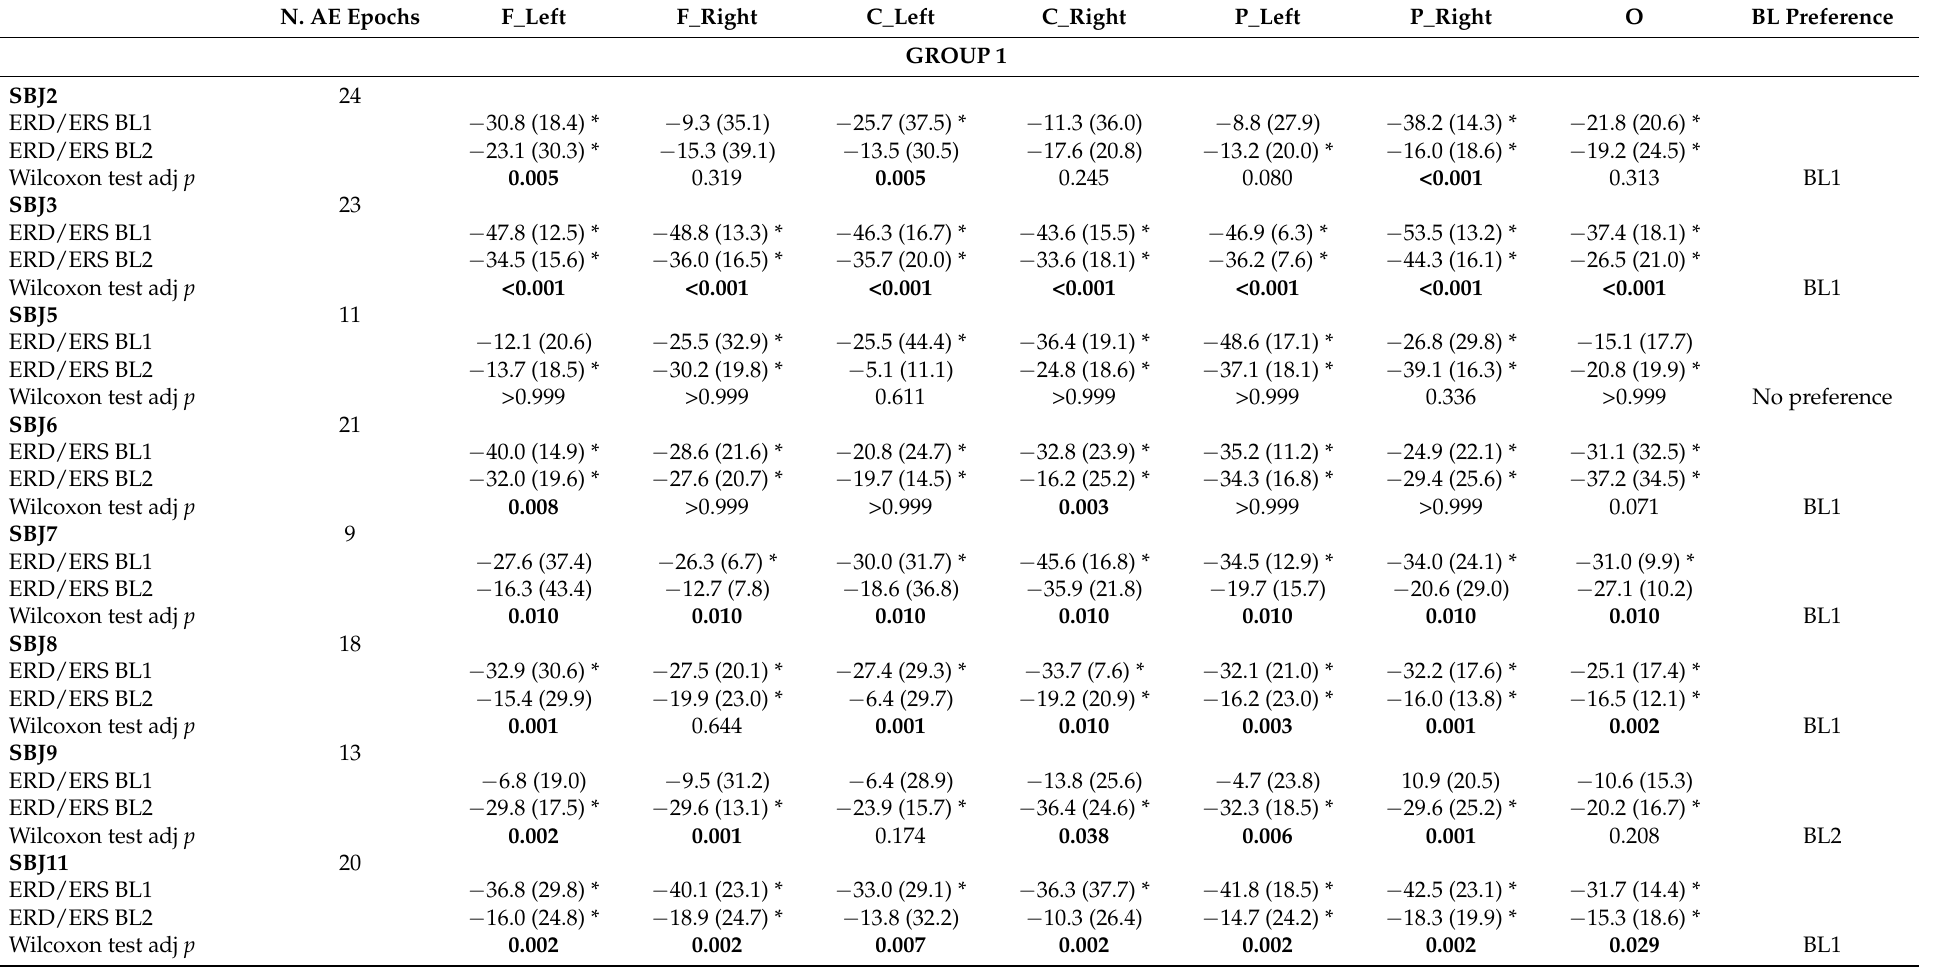
Table 2. The table shows, for each subject, the number of AE epochs analyzed, AE ERD/ERS values (median (IQR)) for each channel cluster and for the two baselines (BL1, BL2), the results of the paired Wilcoxon test comparing AE ERD/ERS computed with BL1 and BL2 (FCR adjusted p -value), the baseline preference. * denotes the significant mu-rhythm desynchronization (One simple Wilcoxon signed rank test, FCR adjusted p -value < 0.050). Results are divided for Group 1, suppressive group , and Group 2, non-suppressive group . N. AE